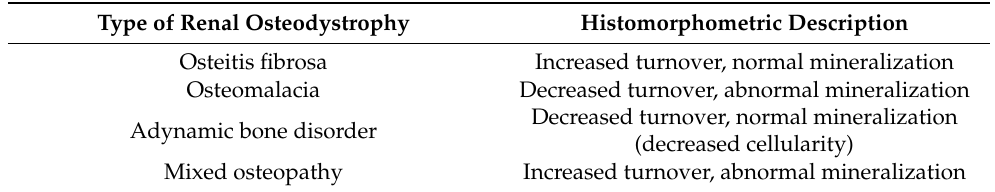
Table 2. Classification of renal osteodystrophy based on turnover and mineralization. The bone volume can be low, normal or high in the various forms of ROD. Type of Renal